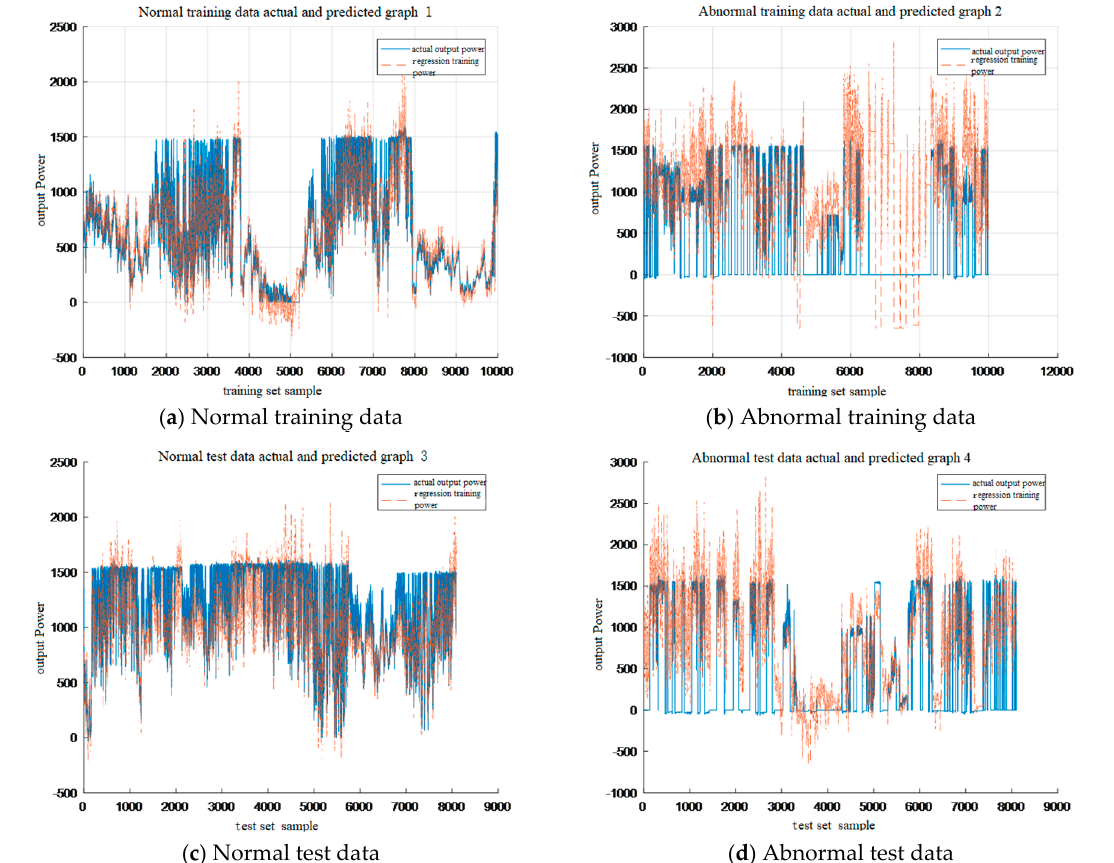
Figure 8. Comparison of output power and actual output power of the training model.